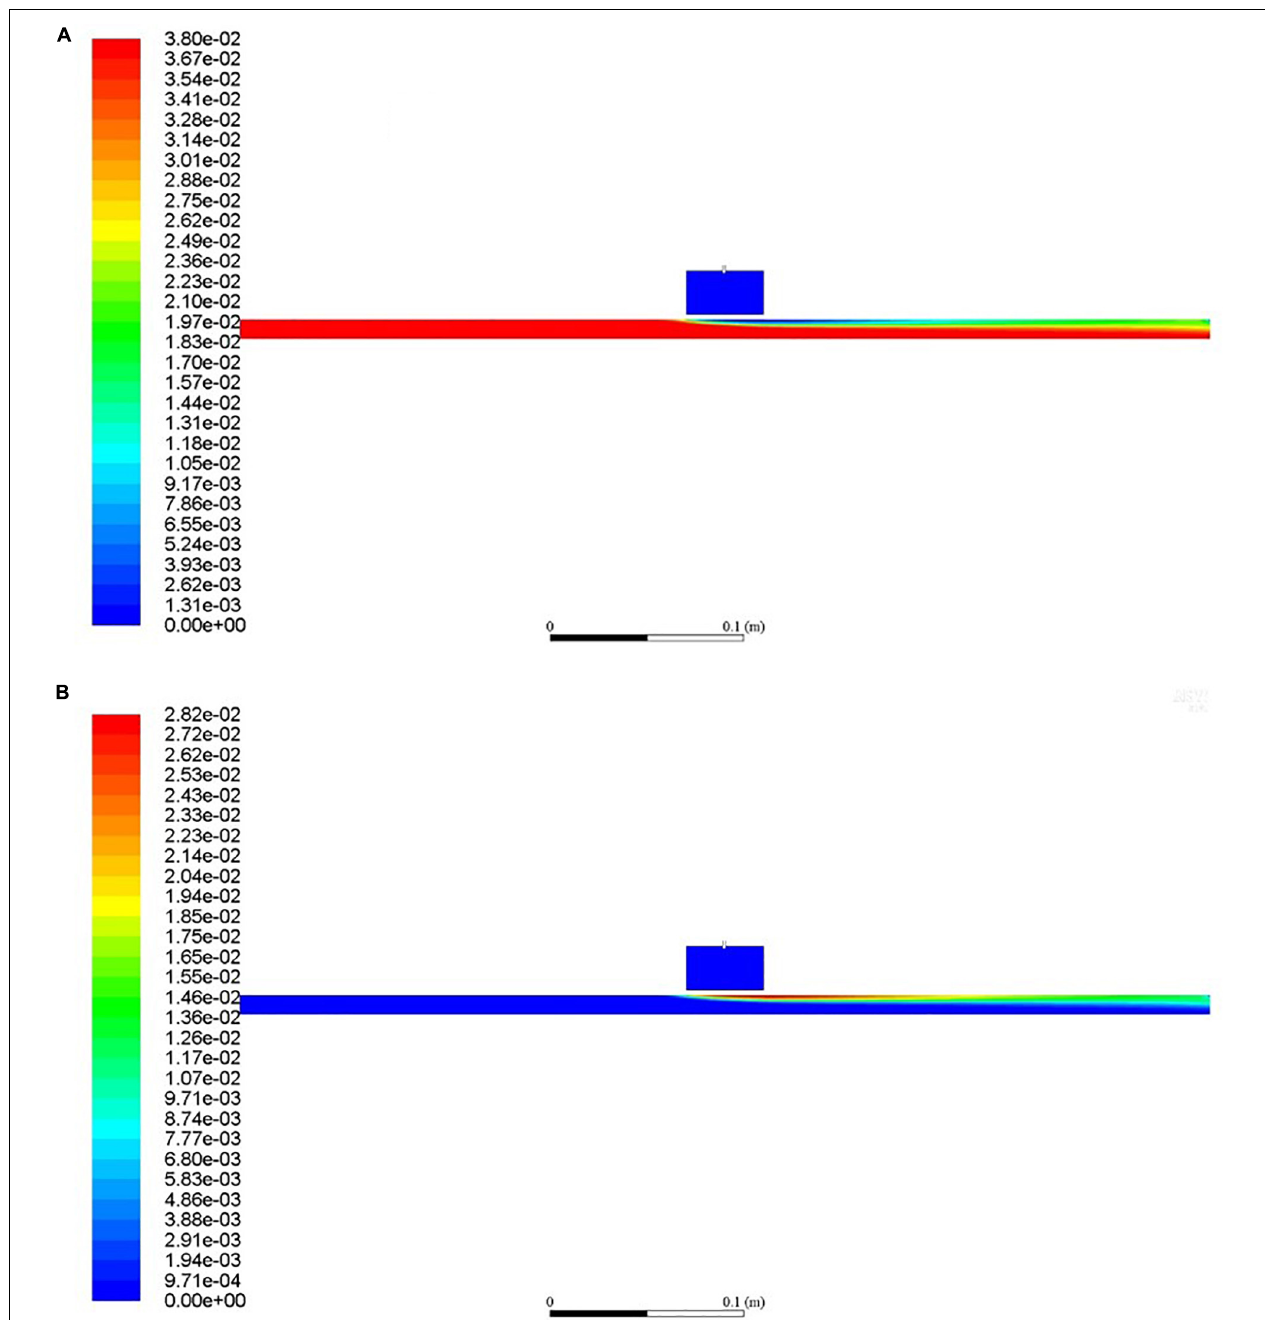
FIGURE 3 | CH 4 (A) and C (B) mass fraction for the single tube